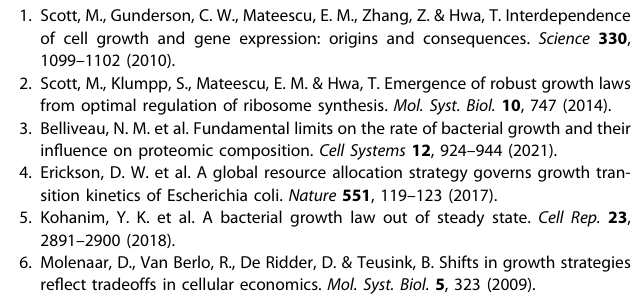
Figure 4 . Panel b : Experimental data comes from Fig. 2b and supplement from Sander et al. 35 . Simulation data comes from Simulation set 17. The model produces counts of amino acids in the cell and a conversion factor to convert from counts to molar concentration (based on Avogadro ’ s number and the current cell volume). These values are multiplied together to produce the concentration.